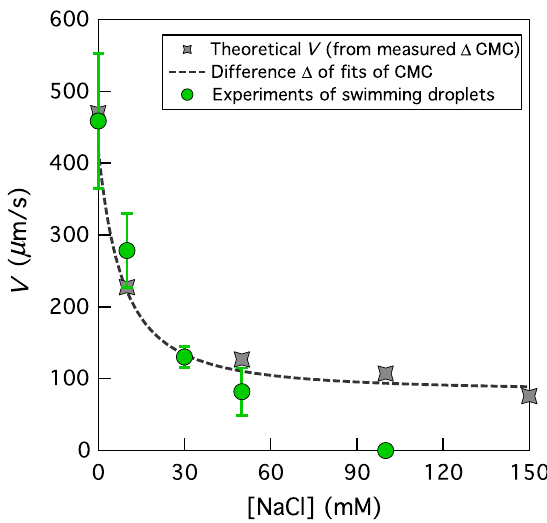
FIG. 4. Instantaneous speed V at a constant ½ SDS (cid:3) ¼ 10 mM sharply decreases with [NaCl]. This trend is theoretically cap- tured by Eq. (1) with Δ CMC values independently measured by pendant drop experiments. Above ½ NaCl (cid:3) ¼ 70 mM, correspond- ing to Δ CMC ¼ 0 . 5 mM, droplets cease to swim. Dashed line is computed from the difference between empirical fits of CMC versus [SDS]